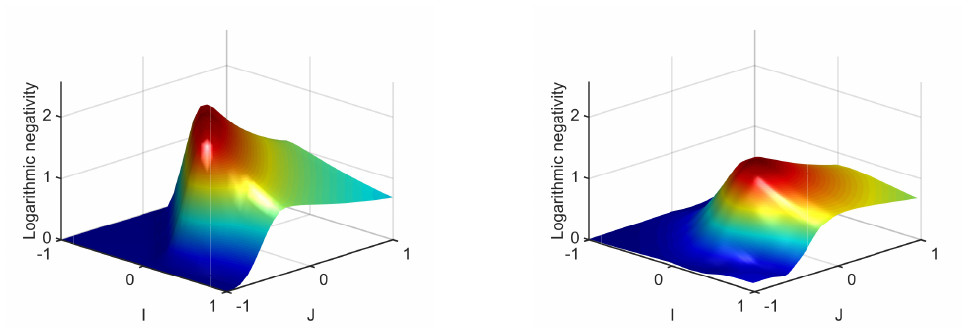
Figure 1: General view of the temperature evolution the entanglement (logarithmic negativity) for K = − 1 at zero applied field. Left panel — low-temperature regime, T = 0.005; right panel — high-temperature regime, T =